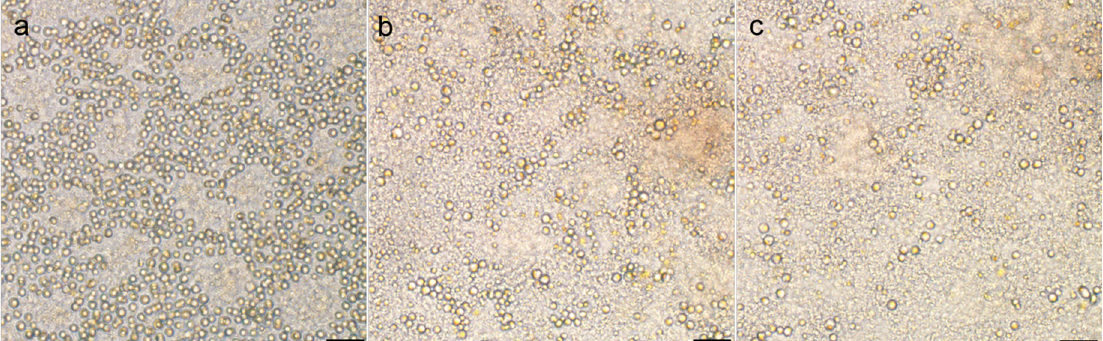
Figure 4. Appearance of resting stage cells of A. anophagefferens strain CCMP1984 after being stored in prolonged periods ( a ) 1 month, ( b ) 2 months, and ( c ) 3 months in darkness at 4 °C. Note that most of the cells died during the storage. Scale bars = 10 μ m.